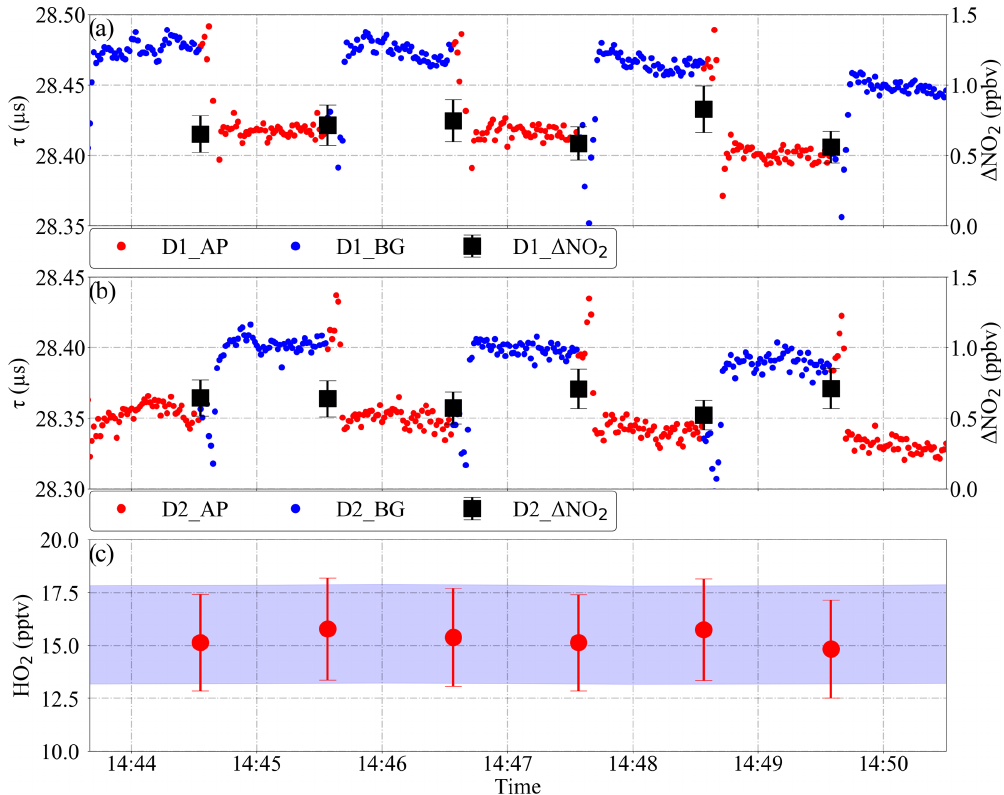
Figure 4. PeRCEAS measurement cycle during the laboratory measurement of 15pptv of HO 2 ; panels (a) and (b) show the ring-down time of detectors 1 (D1) and 2 (D2) in both amplification (AP) and background (BG) modes, and the retrieved (cid:49) NO 2 . The (cid:49) NO 2 and the eCL of the respective reactors are used to retrieve the HO 2 mixing ratio in panel (c) . The blue shading in panel (c) corresponds to the calculated HO 2 mixing ratio produced in the source (2 σ